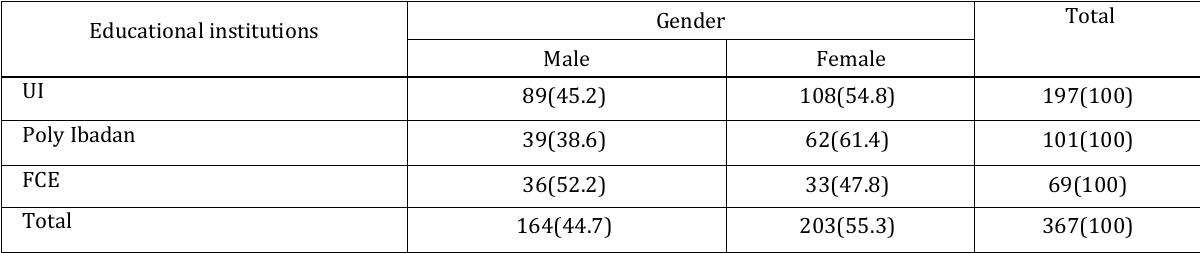
Table 2. Age groups of students (source: Authors’ fieldwork data analysis,